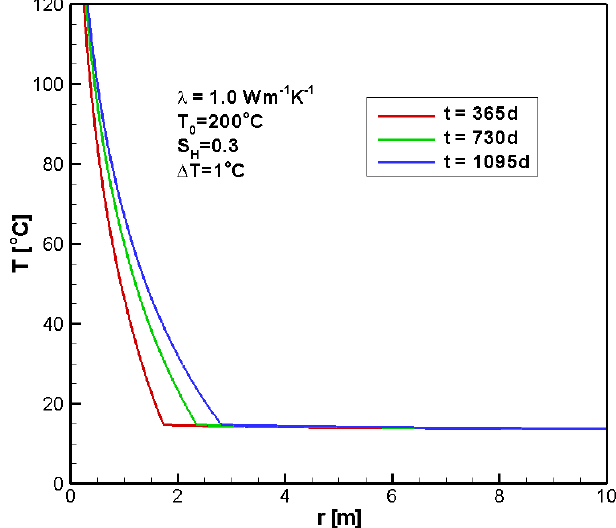
Figure 6. Spatial distribution and temporal evolution of temperature during hydrate production by heat